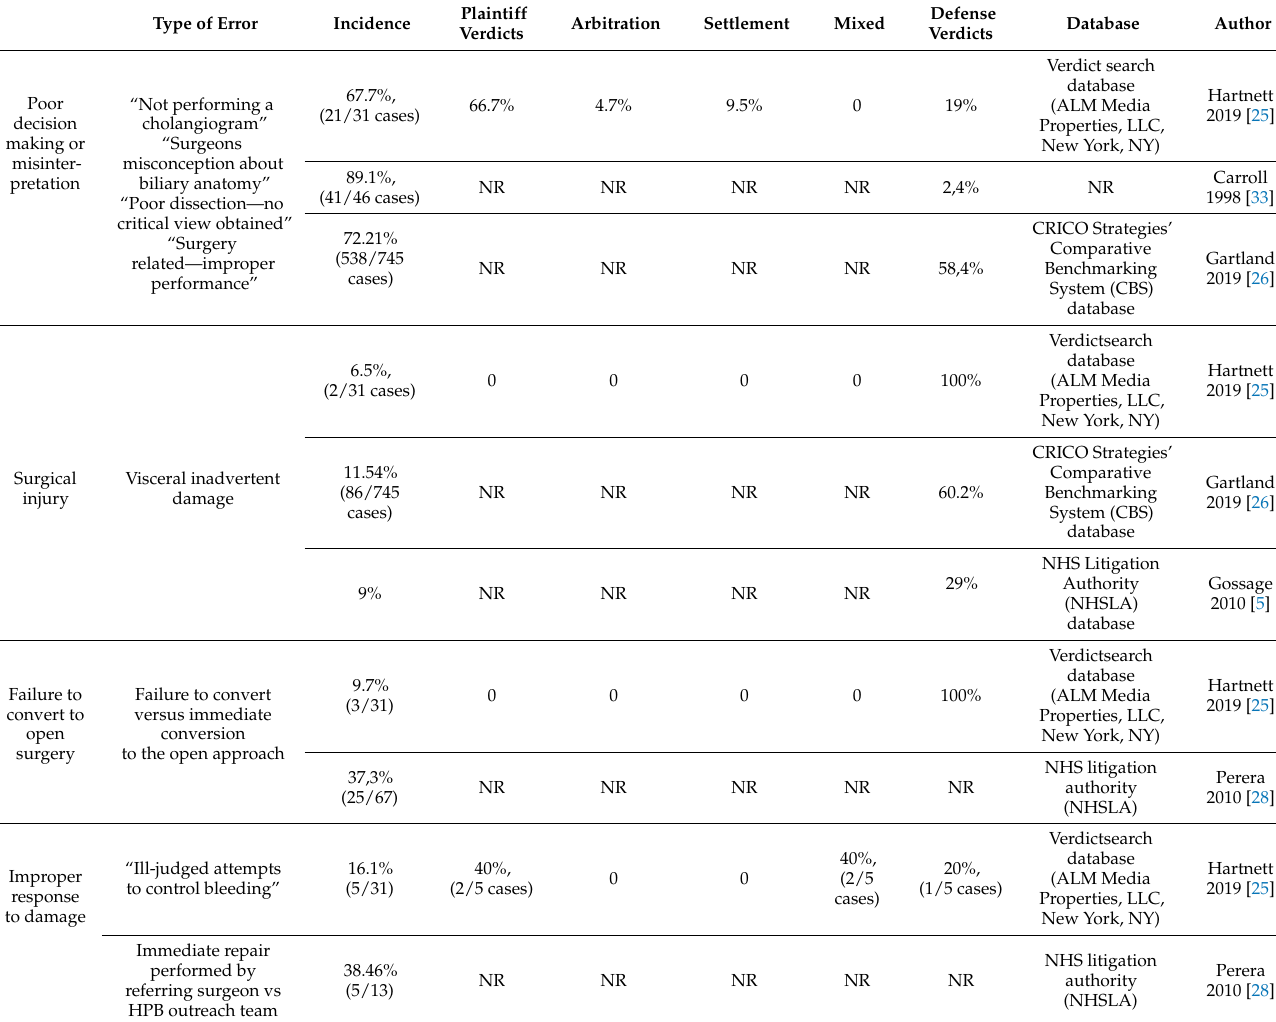
Table 3. Improper intraoperative surgical performance in which malpractice